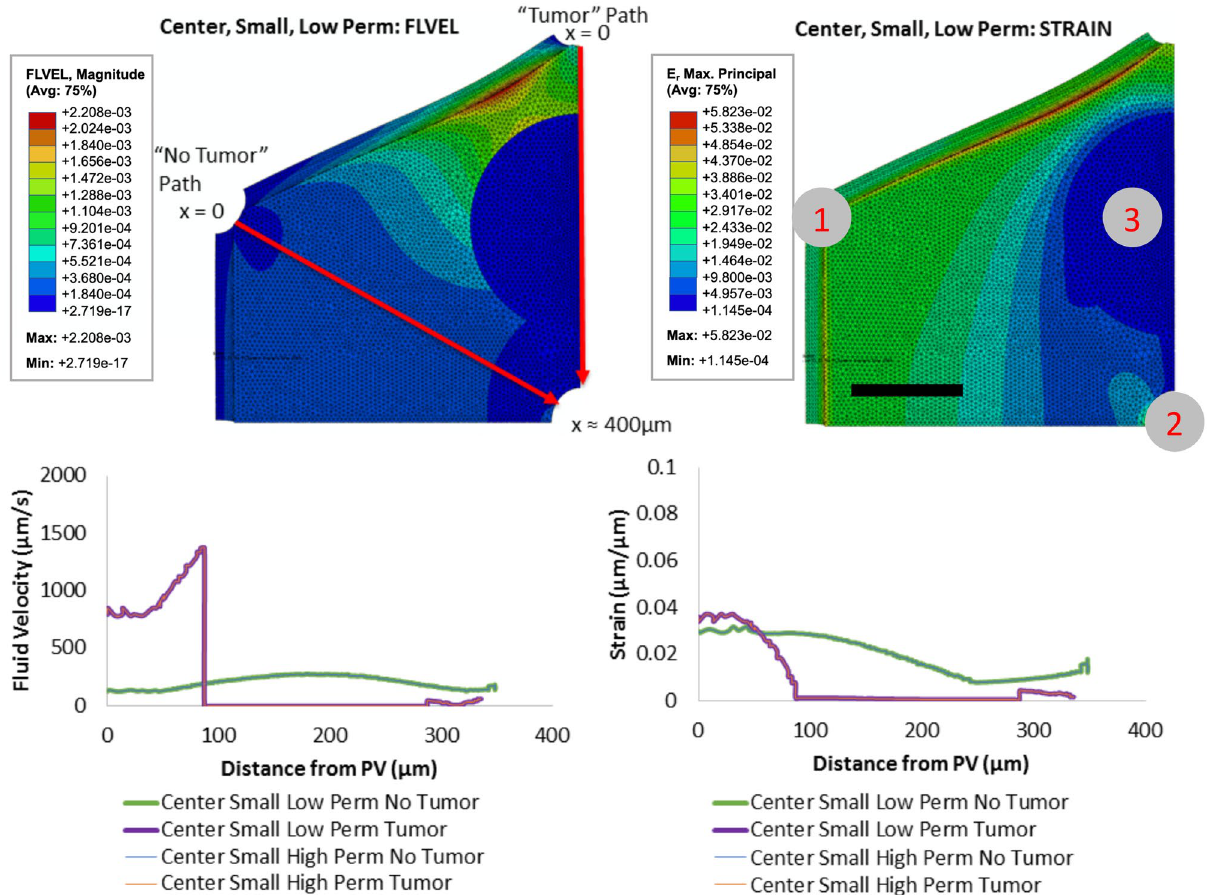
Figure 3. Hepatic flow: small micrometastasis. A 200- µ m micrometastasis disrupts a hepatic lobule, with tumor treated as a net pressure sink. Here, the fluid flow velocity increases “upstream” of the tumor (near portal triad inflow) and decreases near the central vein outlet. The fluid velocity abruptly drops to zero in micrometastases with both high- and low-permeability (left plots). It is noted that the magnitude powers of 4 17 flow of “No Tumor” and “Tumor” paths are 10 − and 10 − respectively in left-top sub-figure. In the right-top sub-figure, 1 is the position of portal triad, 2 is the position of the central vein, 3 is the tumor position. Scale bar: 100 µ